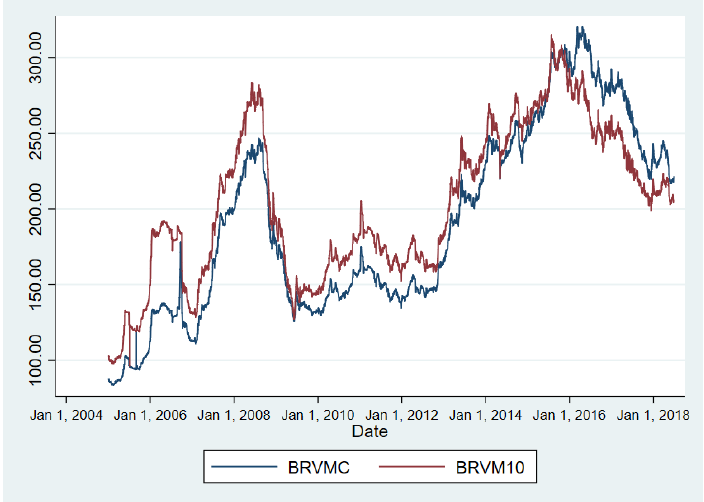
Figure A1. Dynamics of the daily BRVMC and the BRVM 10